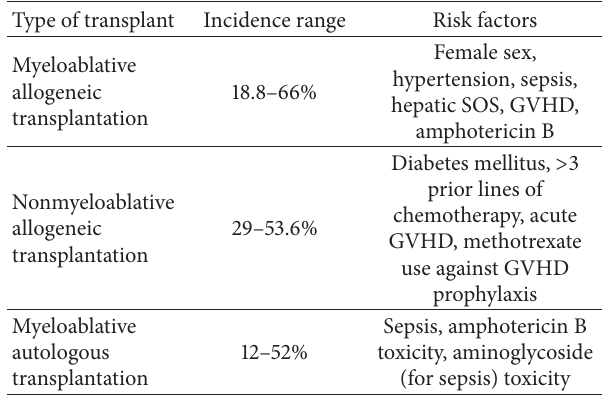
Table 2: Incidence and risk factors for different types of HSCT. Type of